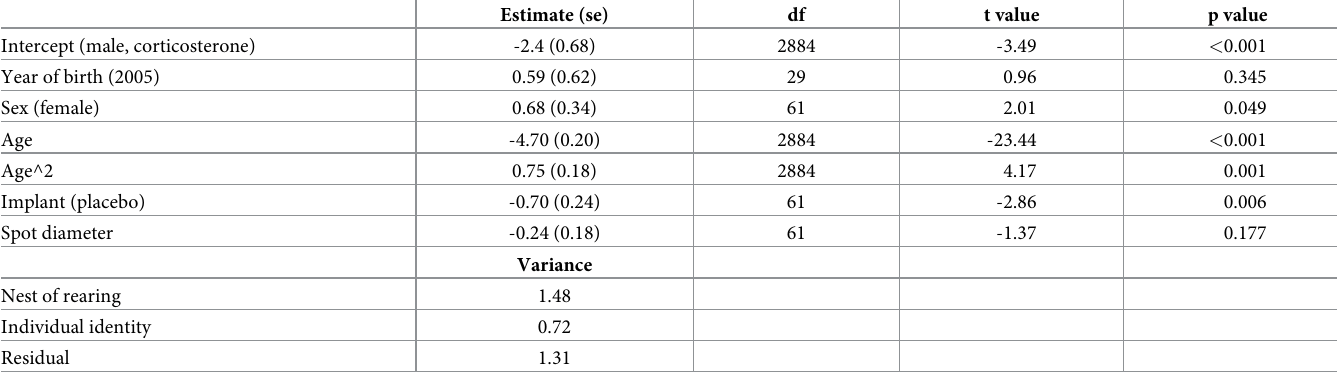
Table 1. Binomial linear mixed model describing the probability to roost in the rearing nest-box depending on year of birth (2004 or 2005), sex, age, implant (corti- costerone and placebo), and diameter of black feather spots in juvenile barn owls.